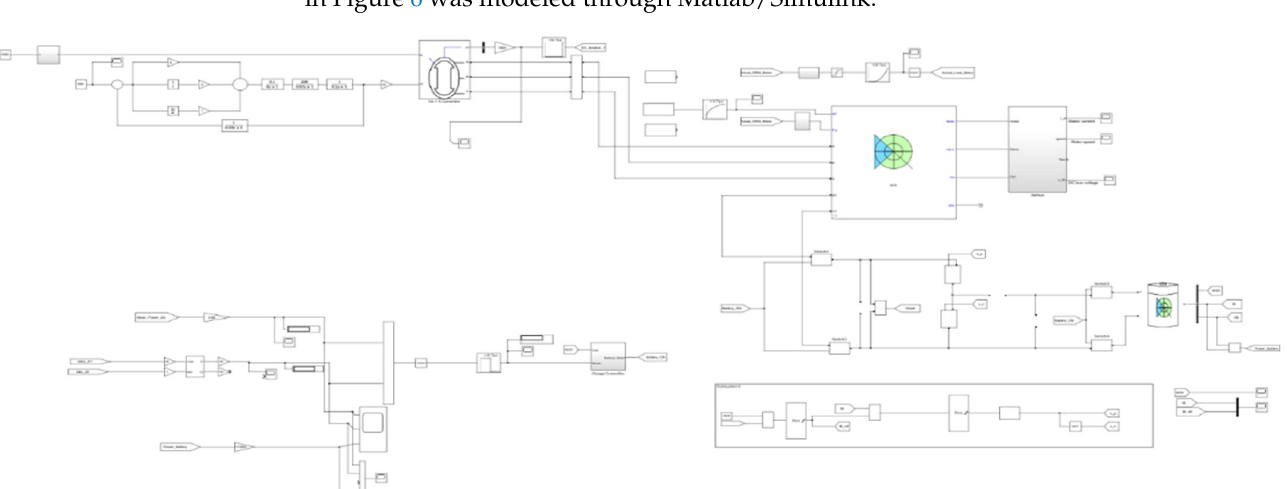
Table 1. Fuel oil consumption, fuel cost, and CO 2 emissions of reference fishing boats.